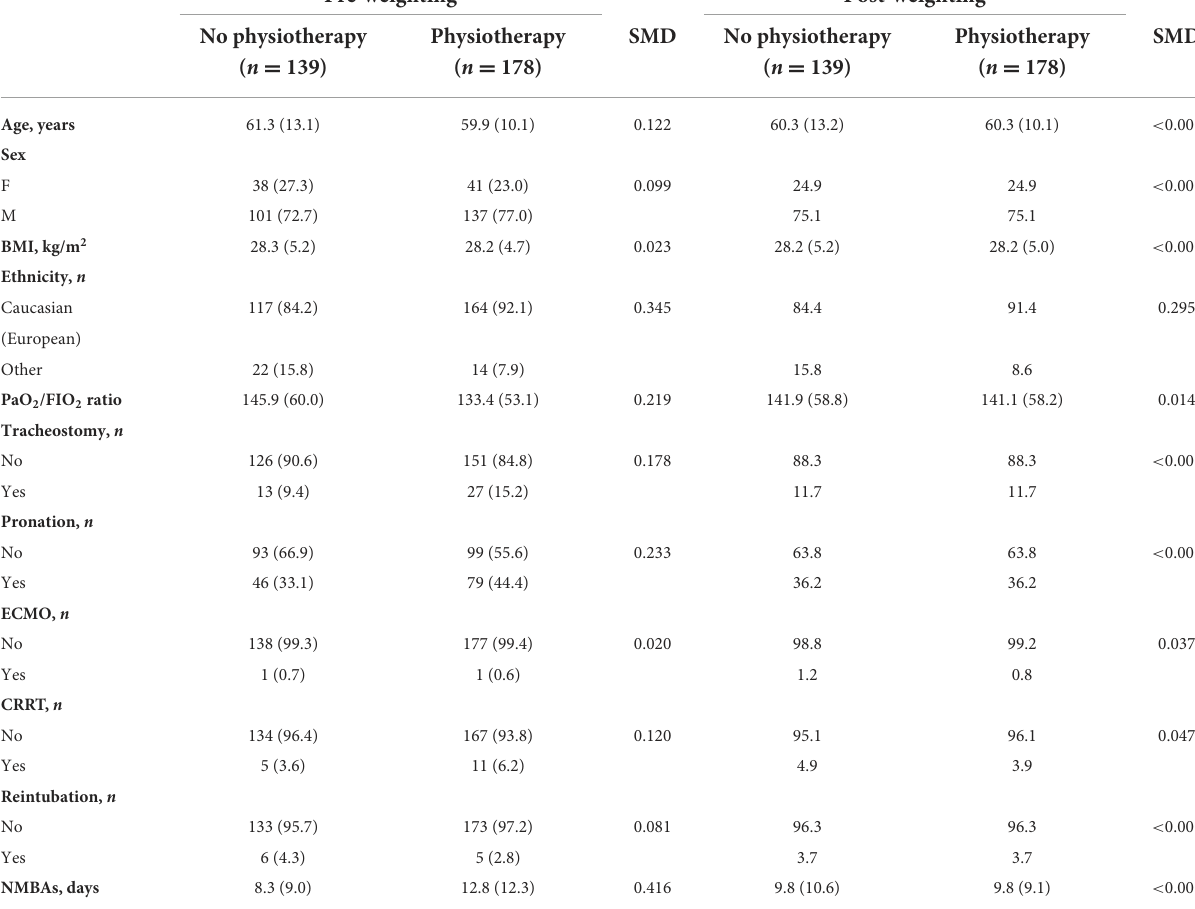
TABLE 1 Baseline characteristics of patients with COVID-19 before and after overlap propensity score-weighting. Pre-weighting